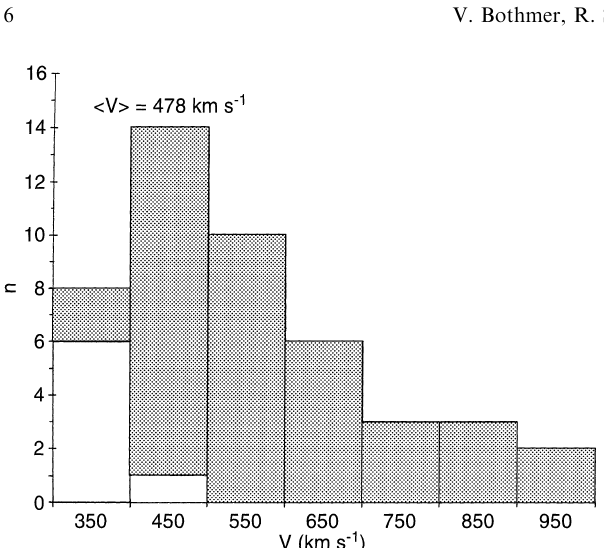
Fig. 2. Frequency distribution for the average proton speeds of MCs in bins of 100 km/s as observed by Helios 1/2 during 1974–1981 between 0.3–1 AU. Open portions of the bars denote the number of MCs not associated with a shock. The average speed for MCs was